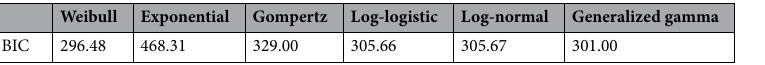
Table 2. BICs of parametric models with time from symptom onset to diagnosis of COVID-19 infection. The sample size N = 165 . We use a Bayesian Information Criterion (BIC) to select the parametric specification that best fits the data. Based on BIC, the model that best fits our data is the Weibull specification. We hence use that specification to estimate our statistical models.